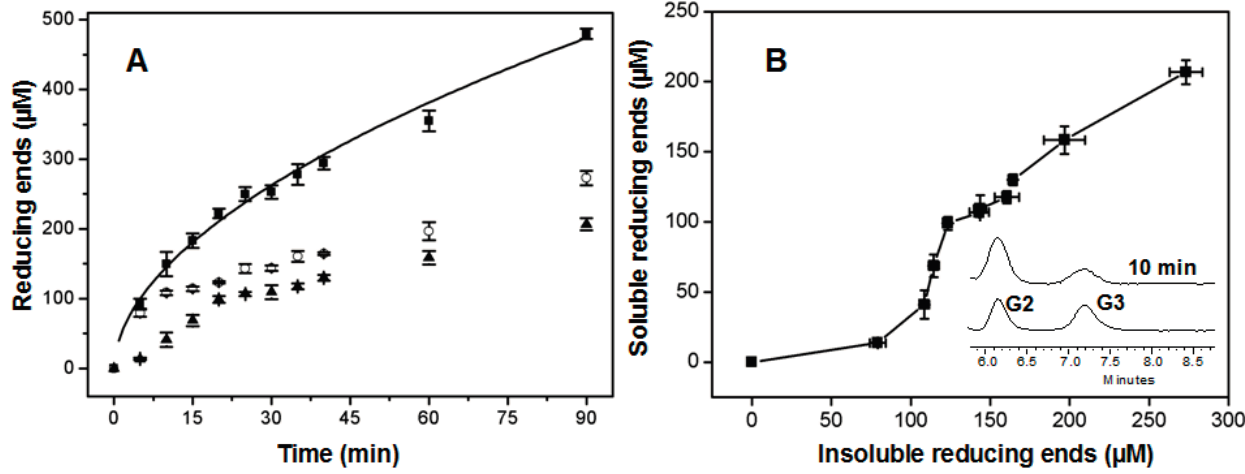
Figure 5. Time course of the hydrolysis of RAC by AcCel12B ( A ) and the distribution of the soluble and insoluble forms of reducing ends ( B ). ( A ) AcCel12B was incubated with RAC and the soluble ( ▲ ) and insoluble ( ○ ) reducing ends formed at the indicated time points were measured. The total amount of reducing ends generated ( ■ ) was then calculated and fitted to Equation (1) (solid line). RAC incubated with thermally inactivated AcCel12B was used as a blank. All data were averaged from triplicate measurements; ( B ) The relationship between the concentrations of soluble and insoluble ends during the reaction is shown. The insert shows representative HPLC chromatograms for the analysis of soluble products after 10 min